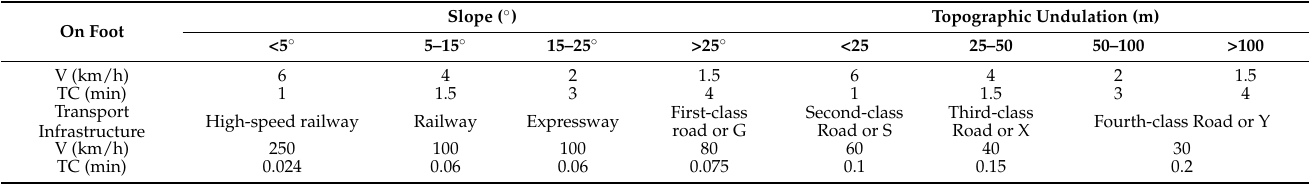
Table 3. Assignment table of V and TC